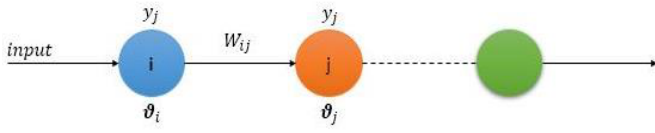
Figure 4. The connection between neurons.